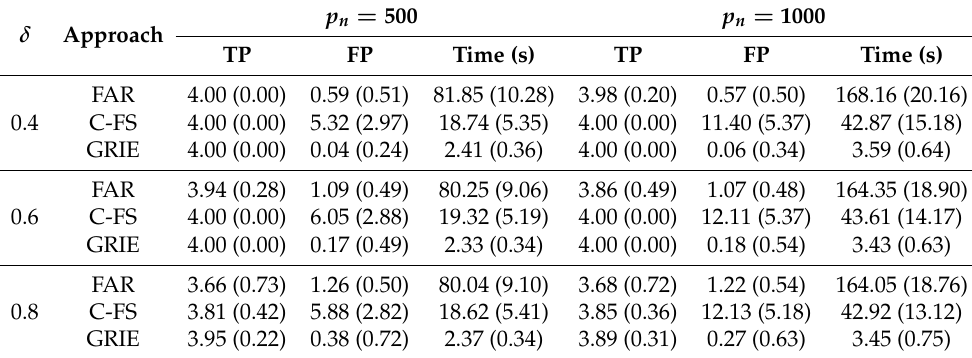
Table 5. Average numbers of true positive (TP), false positive (FP), and calculation time over 100 repetitions and their robust standard deviations (in parentheses) of Example 2 with (cid:101) ∼ N ( 0,1 ) .